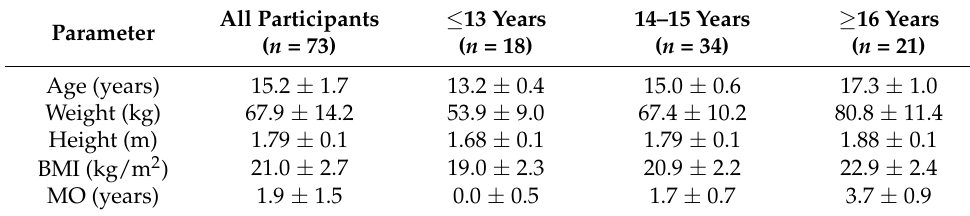
Table 1. Demographic and anthropometric parameters of the participants (mean ± SD). All Participants Parameter ( n =